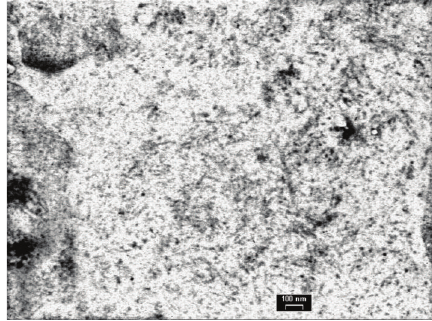
Figure 4: Ultrastructural study ( 1592 × 11 mr) exhibit straight and nonbranching fibrils ranging in diameter from 15–25